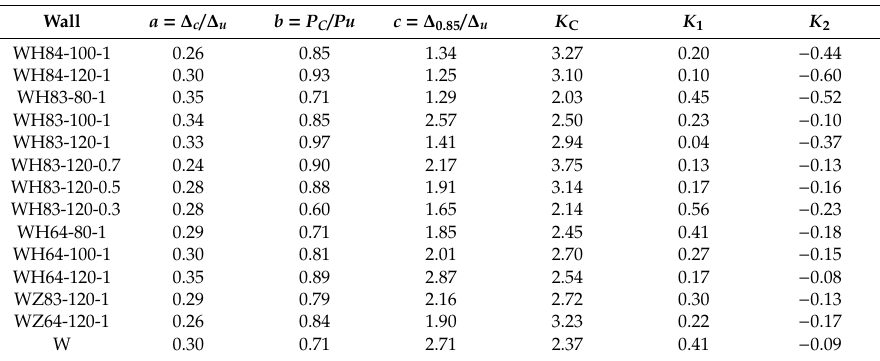
Table 5. Parameters of envelope curves.